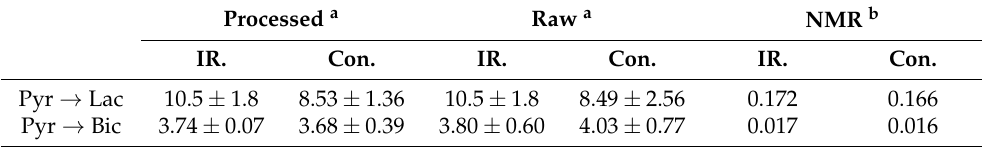
Figure 3. The processed signal after applying our proposed method. ( a ) Pyruvate and downstream metabolite processed signals in the irradiation group. In the control group, the raw signal was compared to the processed signal for ( b ) Alanine, ( c ) Bicarbonate, and ( d ) Aspartate. Table 2. Metaboliteconversioncomparisonbetweentheprocesseddata, rawdata,